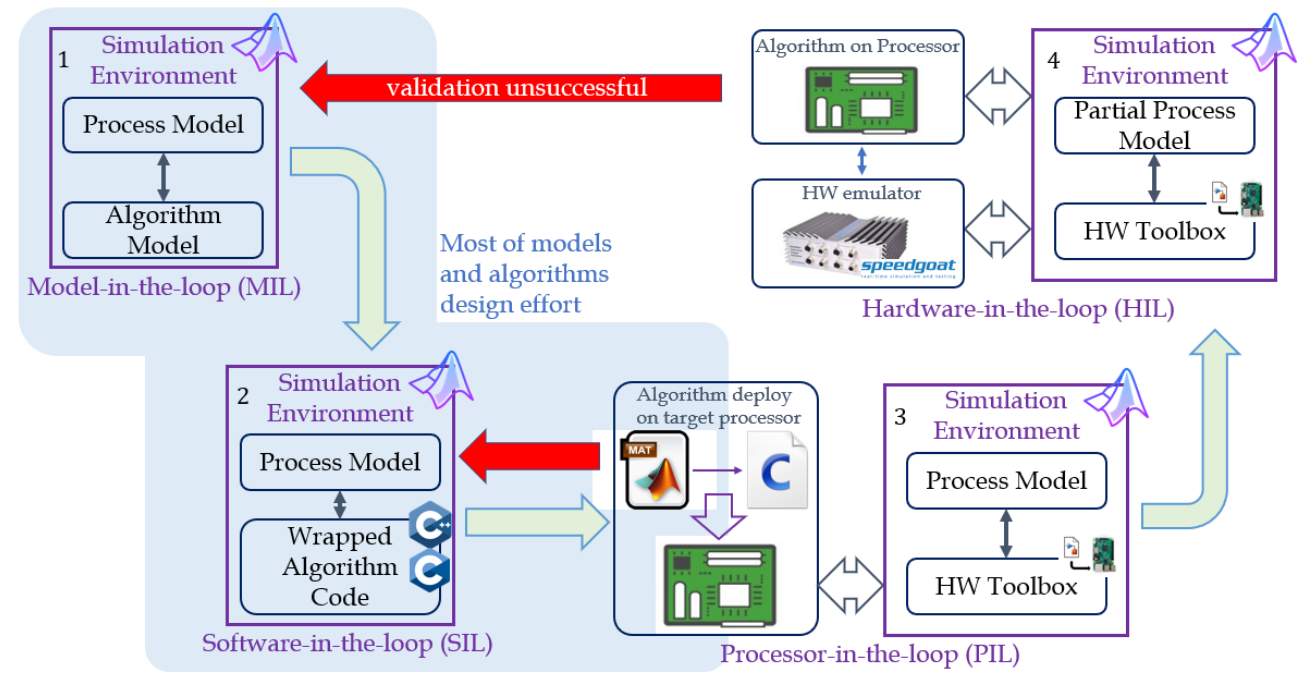
Figure 1. Example of MBD steps for algorithms